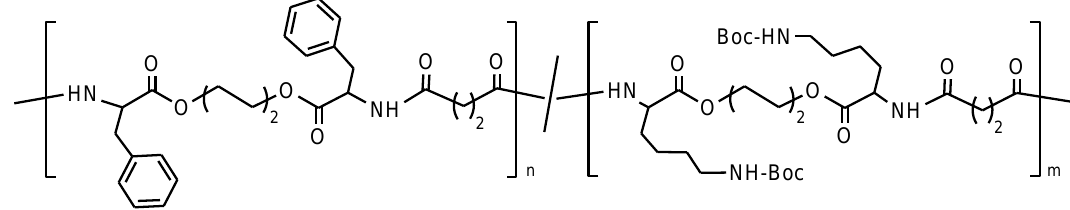
Figure 11. Scheme of functionalized copoly(ester amide)s based on different diester-diamine monomers and succinyl chloride.